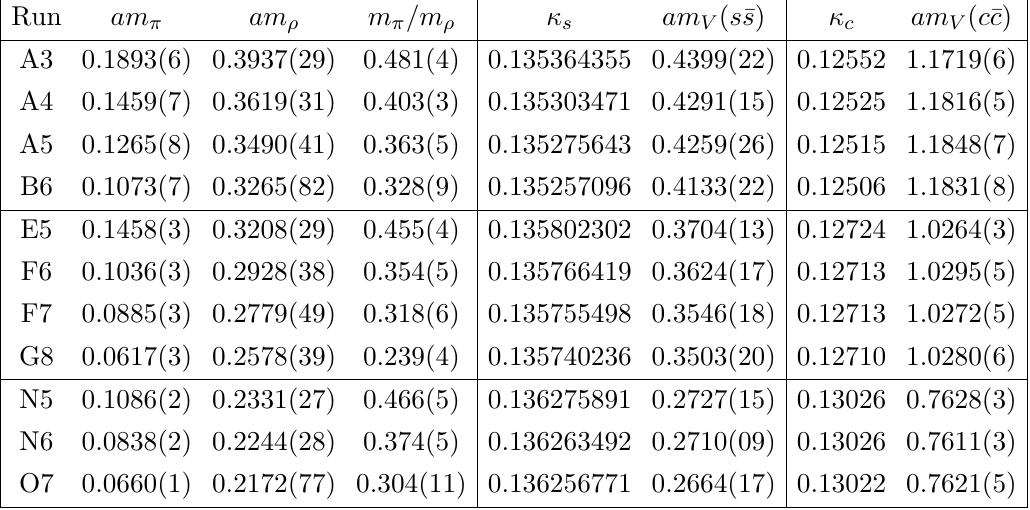
Table 2 . Masses of the pion, the (cid:26) -meson masses, as well as the s (cid:22) s and c (cid:22) c vector states as determined from single exponential